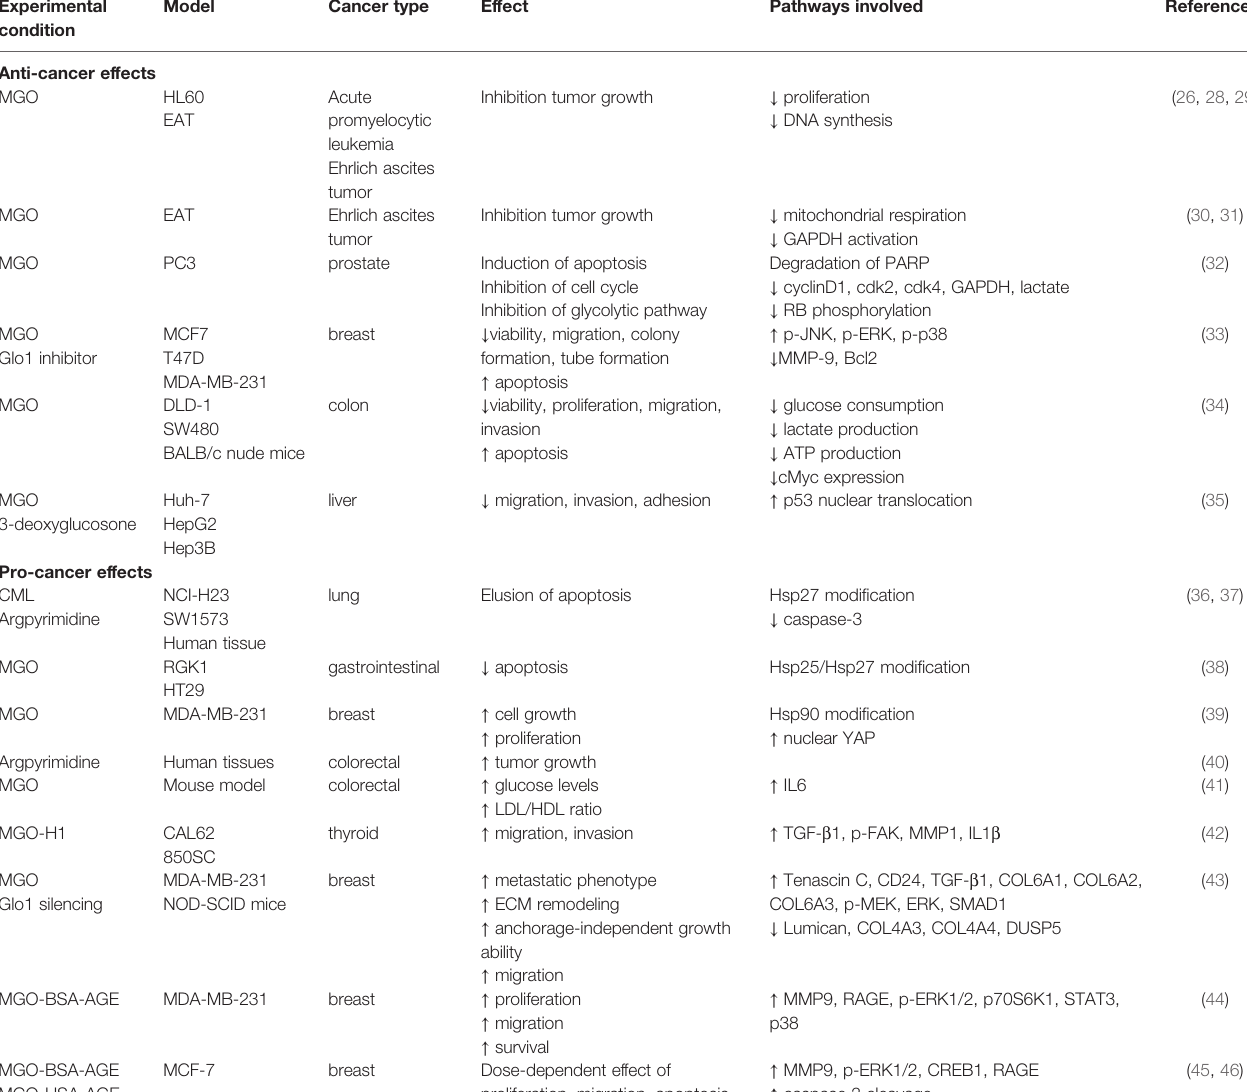
TABLE 1 | Effects of MGO and MGO-induced AGEs in different cancer